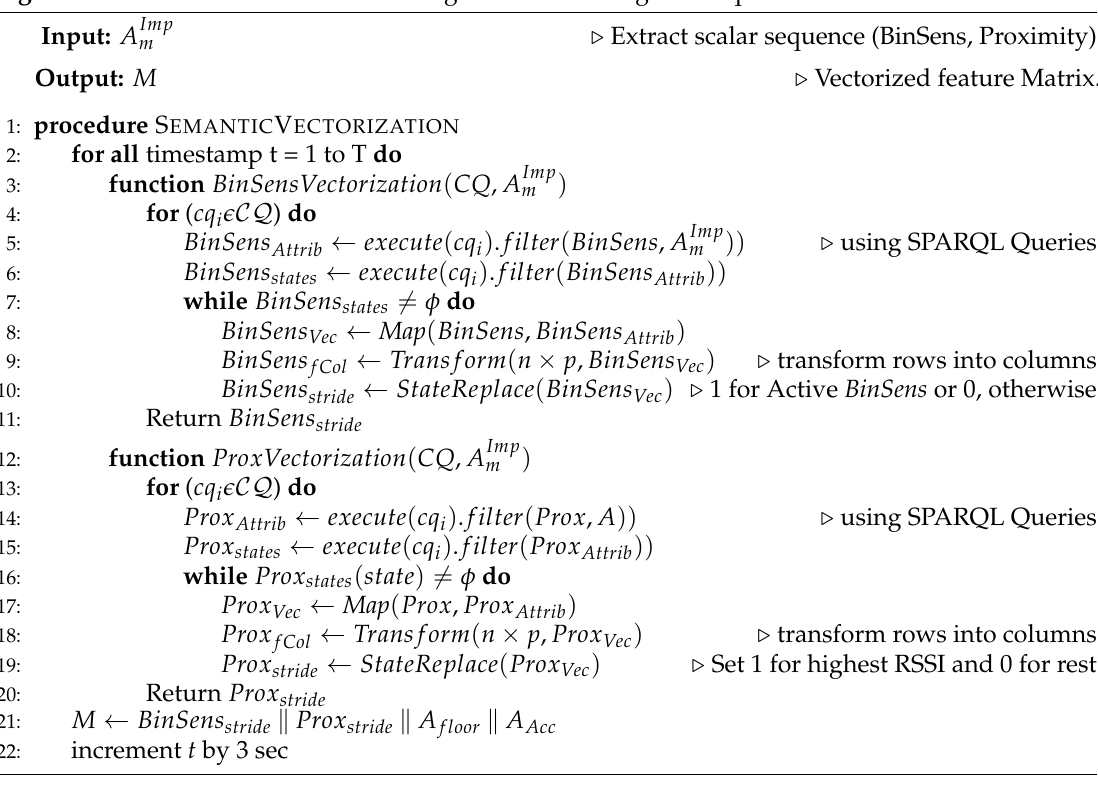
Algorithm 2 Semantic Vectorization Using One-Hot Coding Technique